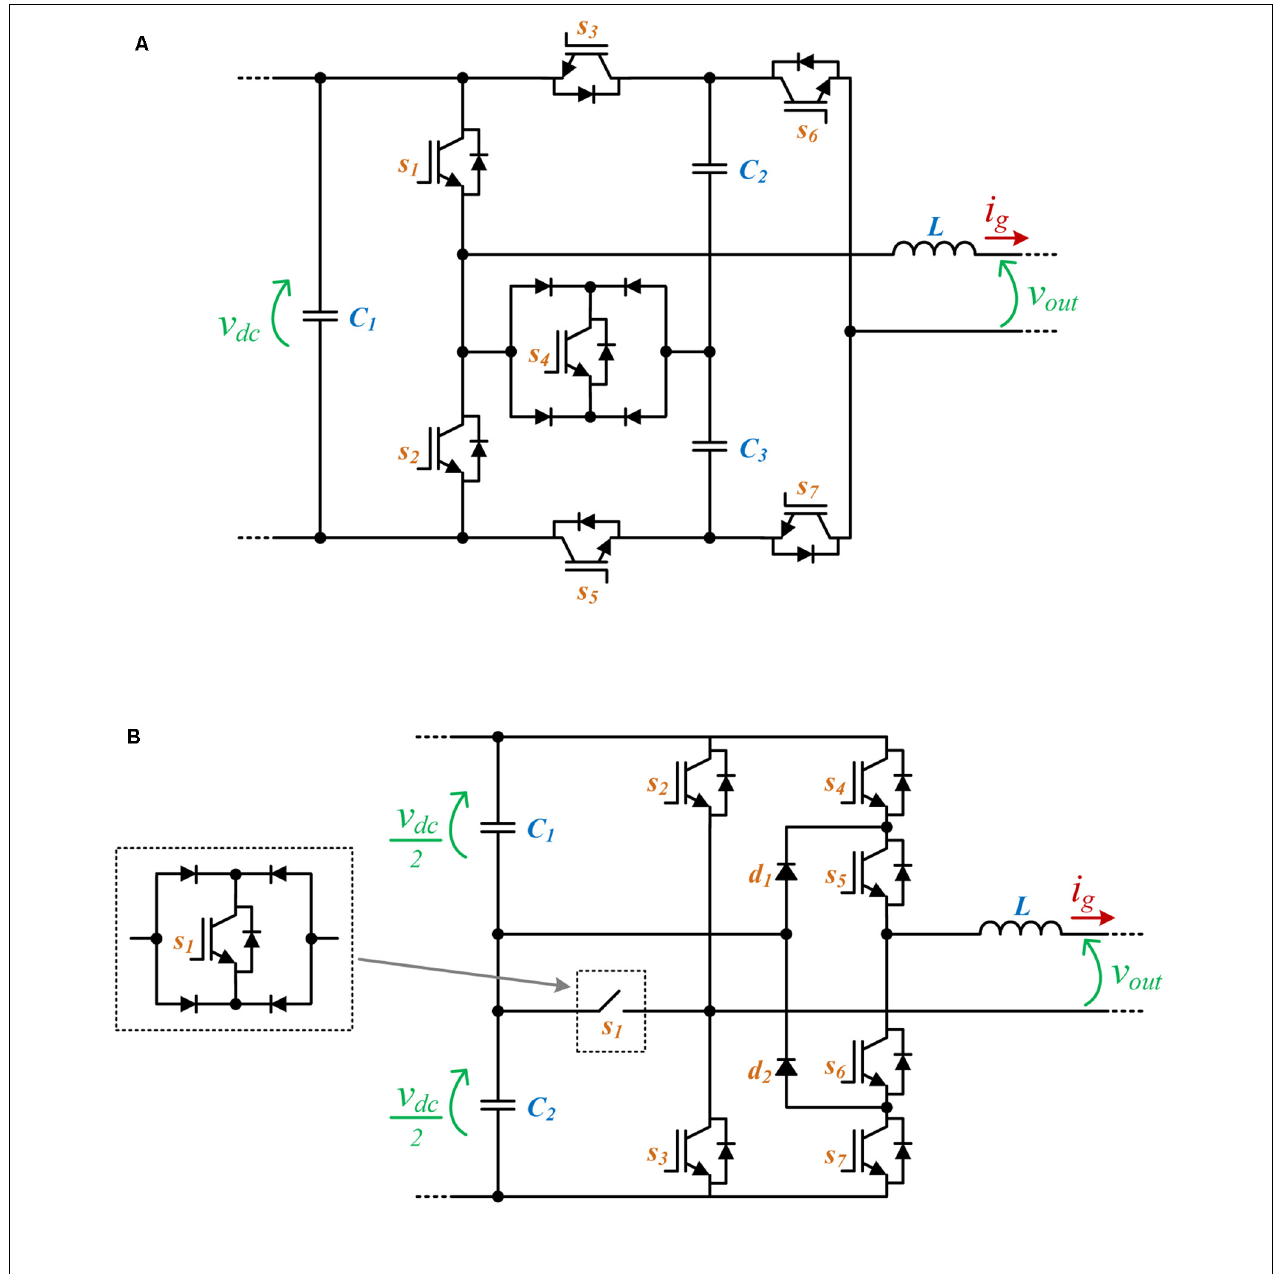
FIGURE 5 | Topologies: (A) proposed in Saeedian et al. (2018); (B) proposed in Madhukar Rao and Sivakumar (2015).